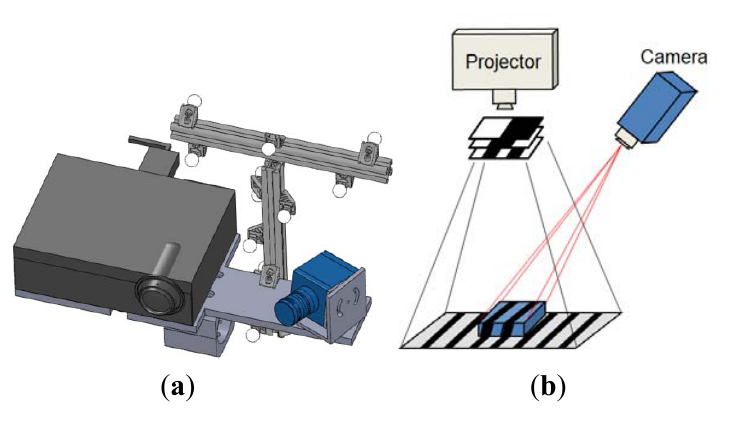
Figure 1. ( a ) Scheme of the 3D optical scanner. ( b ) Fringe pattern